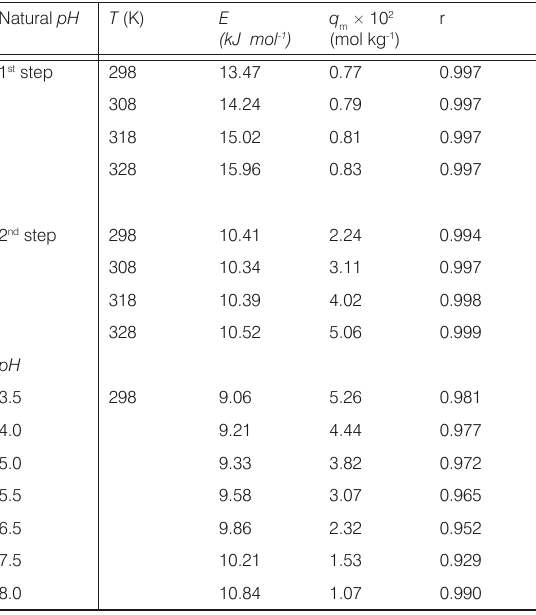
Table 4. The Temkin isotherm parameters for MCPA adsorption on the